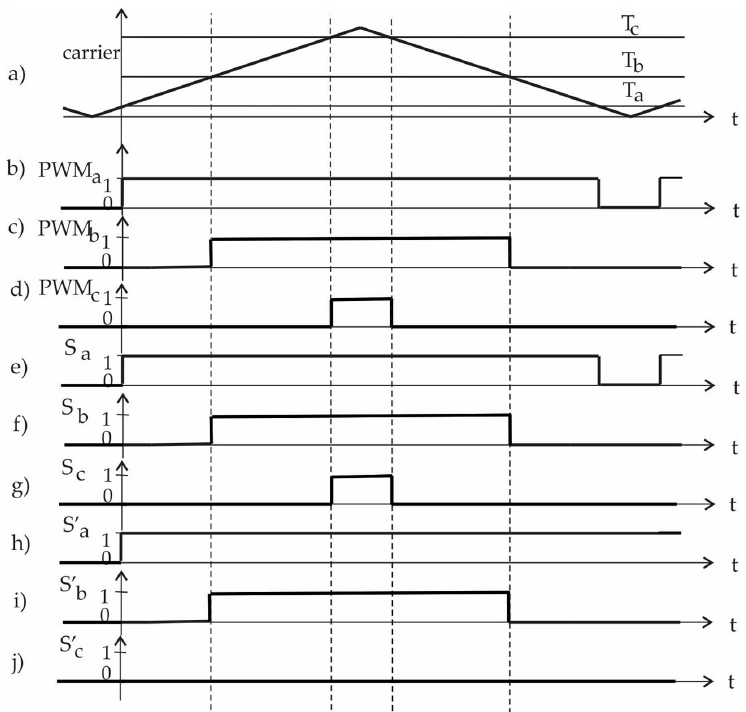
Figure 7. Generation of PWM signals, and conventional active rectifier switching states. ( a ) High-frequncy triangular carrier signal; ( b ) digital signal PWM a ; ( c ) digital signal PWM b ; ( d ) digital signal PWM c ; ( e ) switching state S a ; ( f ) switching state S b ; ( g ) switching state S c ; ( h ) digital signal S’ a ; ( i ) digital signal S’ b ; ( j ) digital signal S’ c .